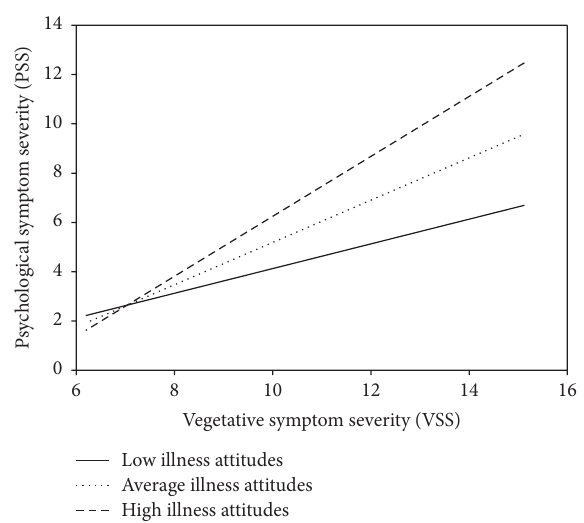
Figure 1: Illness attitudes to fatigue moderate the VSS-PSS relation-